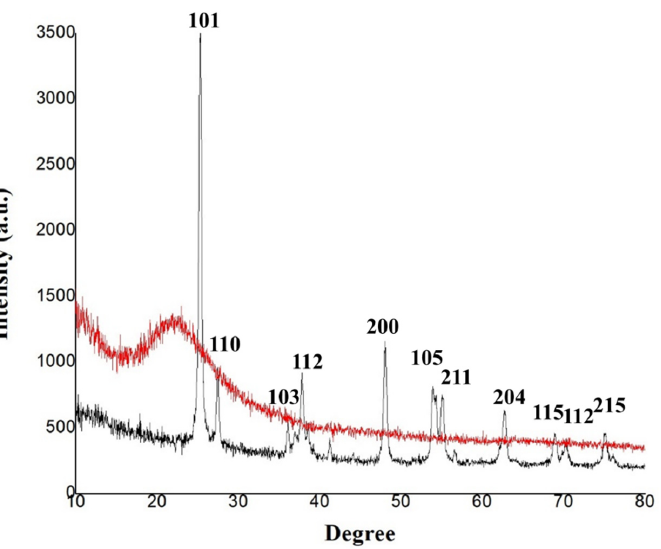
Figure 4. The XRD spectra of SiO 2 (red pattern) and TiO 2 NPs (black pattern).